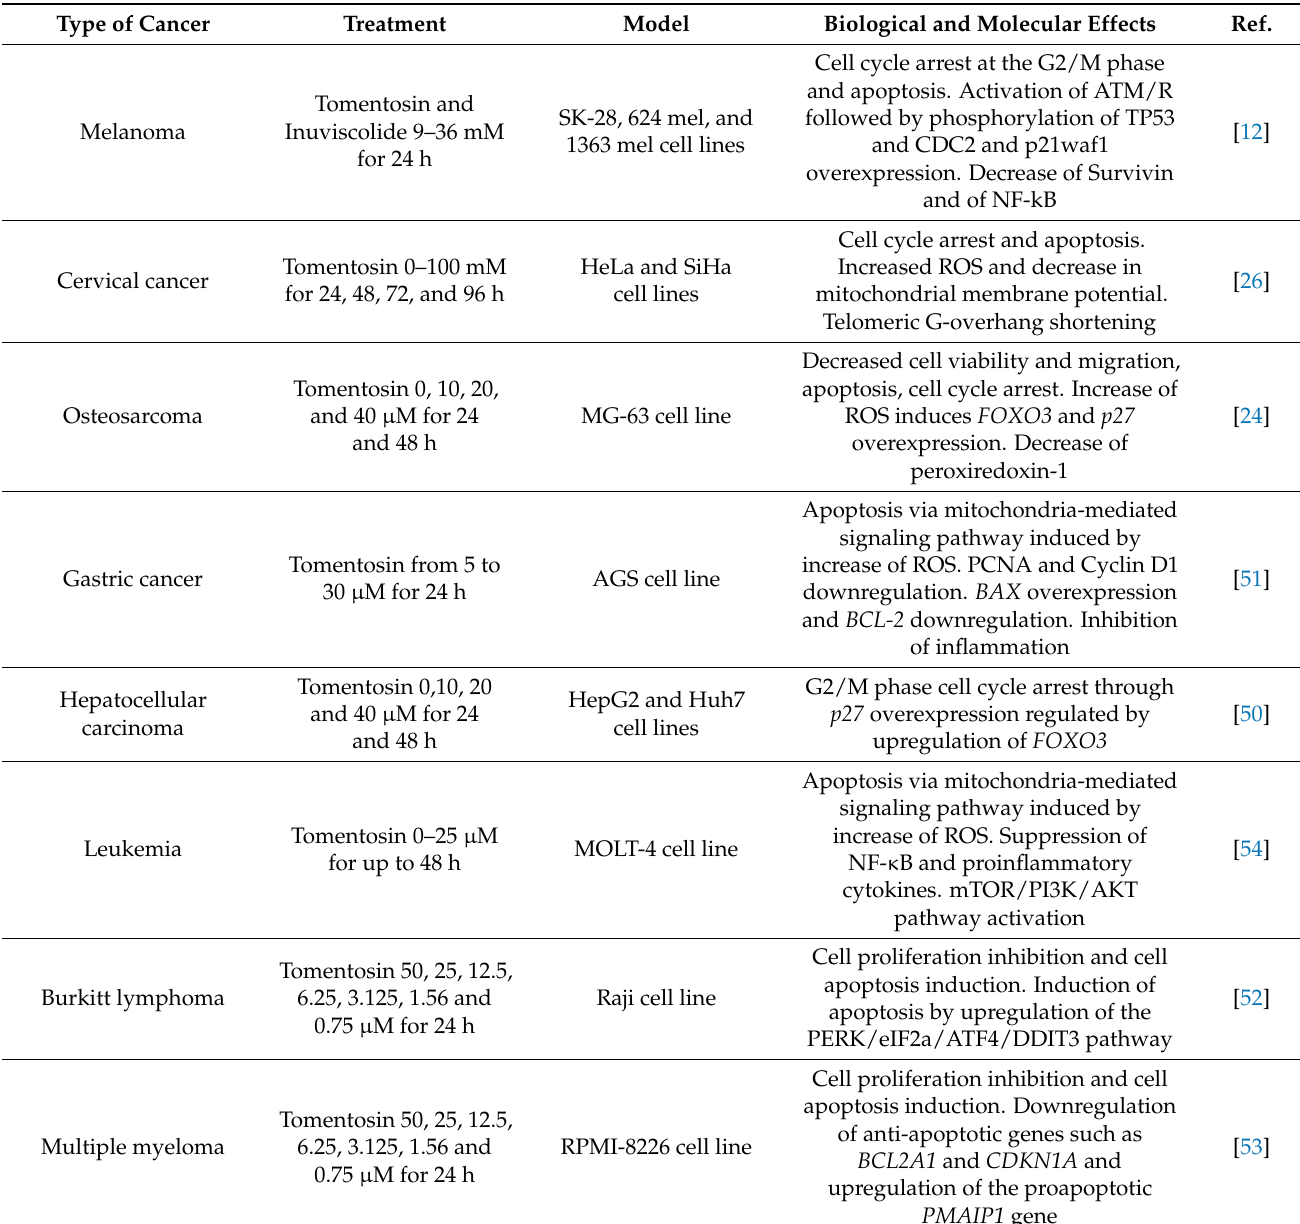
Table 2 summarizes the biological and molecular effects induced by SLs treatment within in vitro system models. Figure 1 describes the prevalent proapoptotic molecular mechanisms induced by SLs treatment in human tumors. Table 2. Summary of the biological and molecular effects of sesquiterpene lactones treatment with in vitro system